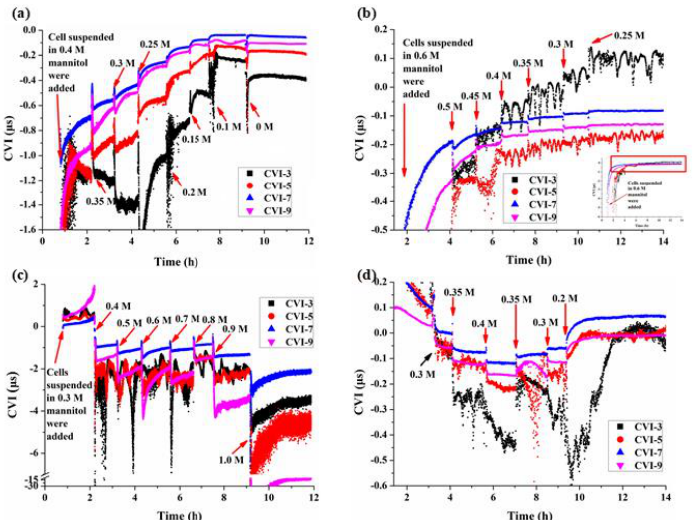
Figure 3. Dynamic viscoelastic changes of BY-2 cells under different osmotic conditions accompanied with changes in mannitol concentrations. ( a ) C M dropped from 0.4 M to 0 M, ( b ) C M dropped from 0.6 M to 0.25 M, ( c ) C M increased from 0.3 M to 1.0 M, ( d ) C M increased first from 0.2 M to 0.4 M then dropped to 0.2 M.